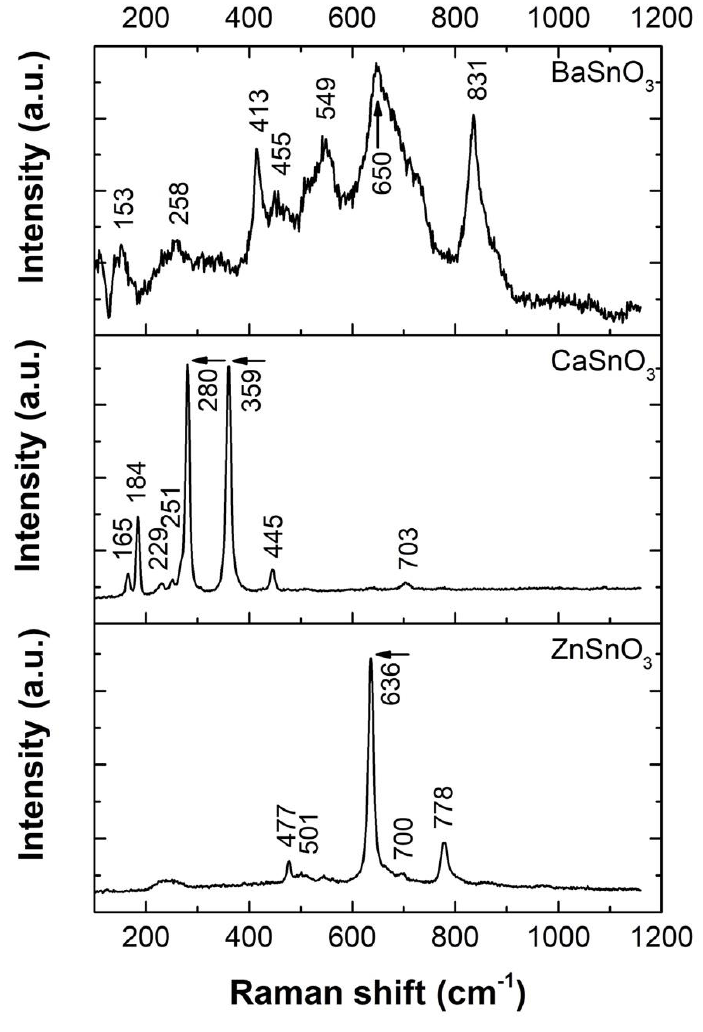
Figure 6. Room temperature (23 °C) Raman spectra of the sintered ceramic bodies based on MSnO 3 perovskites (M = Ba, Ca, Zn).